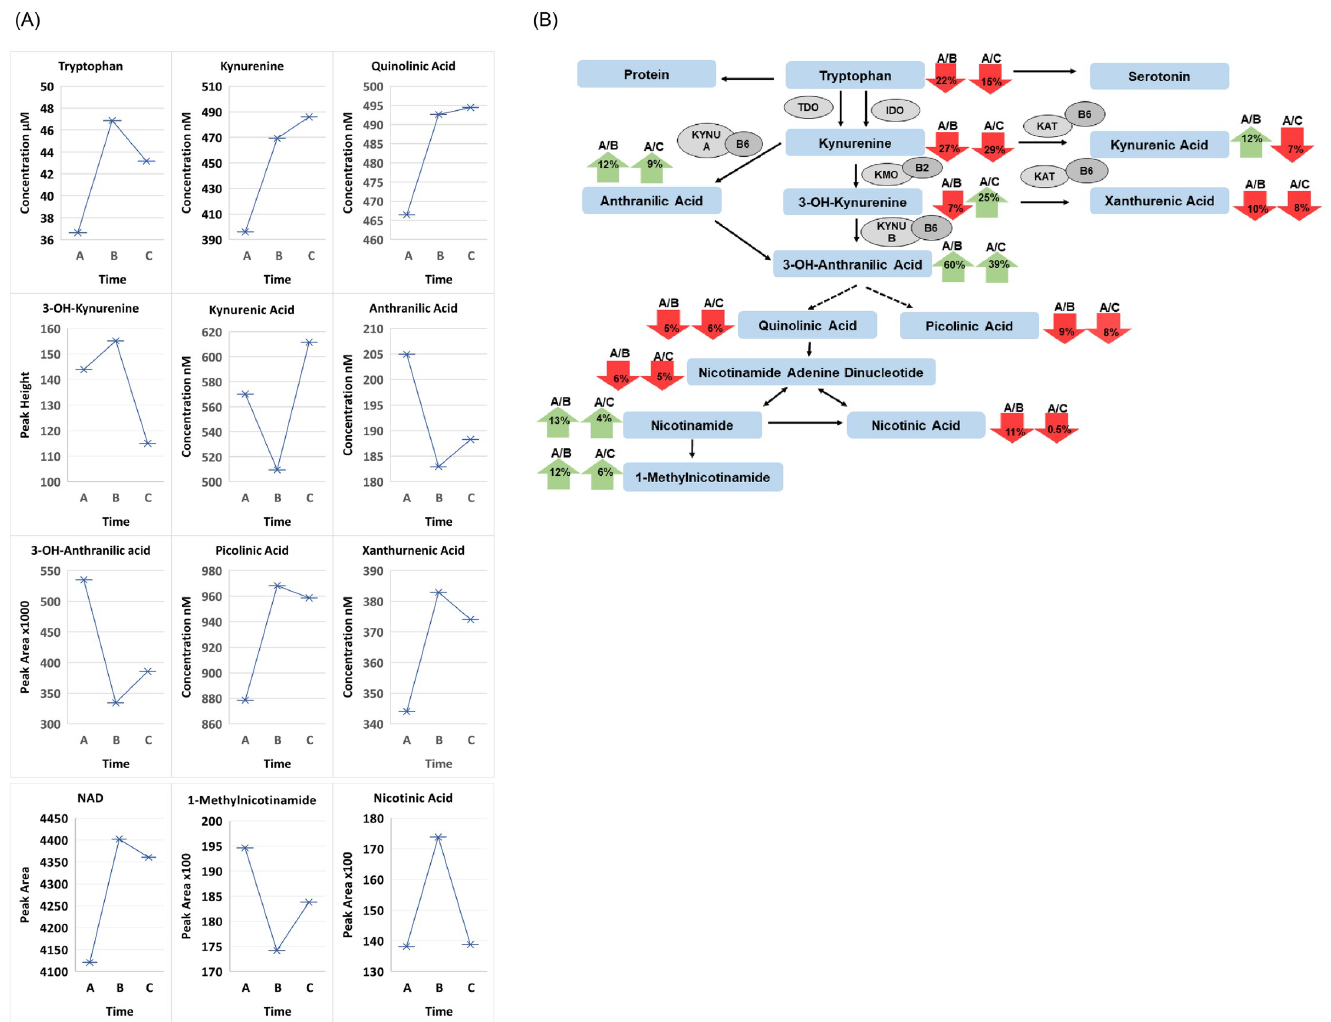
Fig 1. A . Comparison of treatment for all patients over 3 time points for the metabolites Time A at 6-12hours, Time B at 2 weeks and Time C at 3 months between all patients for tryptophan, kyunrenine, quinolinic Acid (QA), kynurenic acid (KA), 3-OH-anthranilic acid, anthranilic acid, picolinic acid, xanthurenic acid, nicotinamide adenine dinucleotide (NAD), 1-methylnicotinamide and nicotinic Acid. B . Flow diagram of tryptophan/kynurenine pathway. Pathway displaying the percent change differences between Time A divided by Time B and Time A divided by Time C. Red indicates a decrease while green indicates an increase. Major enzymes and cofactors in the Trp/KP: indoleamine 2,3-dioxygenase (IDO); tryptophan-2,3-dioxygenase (TDO); kynurenine aminotransferase (KAT); and kynurenine 3-monooxygenase (KMO); L-kynureninas A and B (KYNU A and KYNU B); vitamin B6; and vitamin B2. https://doi.org/10.1371/journal.pone.0254116.g001 severe DKA. This extensively studied system in the brain involves aspartate, glutamine, gluta- mate [59], n-acetyl-glutamate and taurine, a protective neuronal metabolite [60, 61]. Only aspartate was increased during treatment (A), decreased at two weeks (B), and rebounded at 3 months to greater than (A). At time (A) there was decrease in glutamine and glutamate, with the greatest difference in N-acetylglutamate (p-value 0.0216 for Time A vs. B and 0.015552 for Time A vs. C) and for taurine (p-value 0.0838 for Time A vs. C; Fig 3). The EAAs in the extracellular fluid of vasogenic BE are involved in the pathogenesis of initial and secondary neuronal injuries and inhibited by KYNA modulation of the AA receptors [62, 63]. This too indicates a possible role for EAAs in the pathogenesis of DKA’s pretreatment subclinical BE [27, 29].